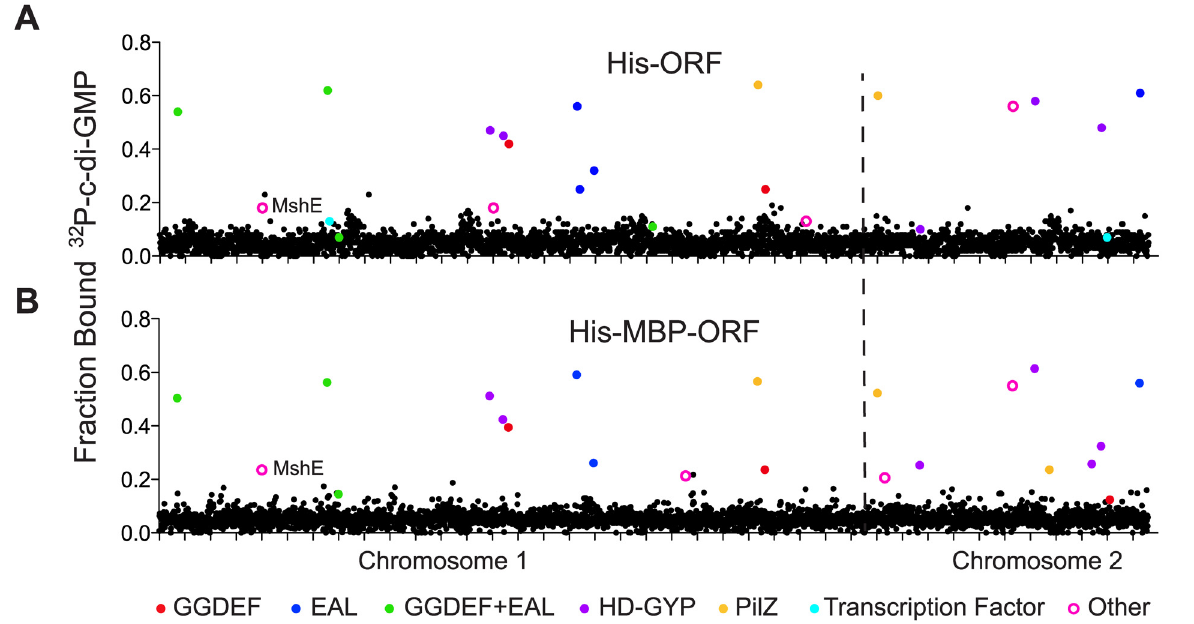
Fig 1. Primary DRaCALA screen of Vibrio cholerae ORF libraries. Average fraction bound 32 P-c-di-GMP vs. individual V . cholerae (A) His-ORFs and (B) His-MBP-ORFs overexpressed in E . coli whole cell lysates. ORFs are arranged by VC gene number along the X-axis. ORFs validated as positive in the secondary screen are indicated by color and classified by type of c-di-GMP-binding protein. “ Other ” refers to proteins that have not been predicted or demonstrated to bind c-di-GMP.